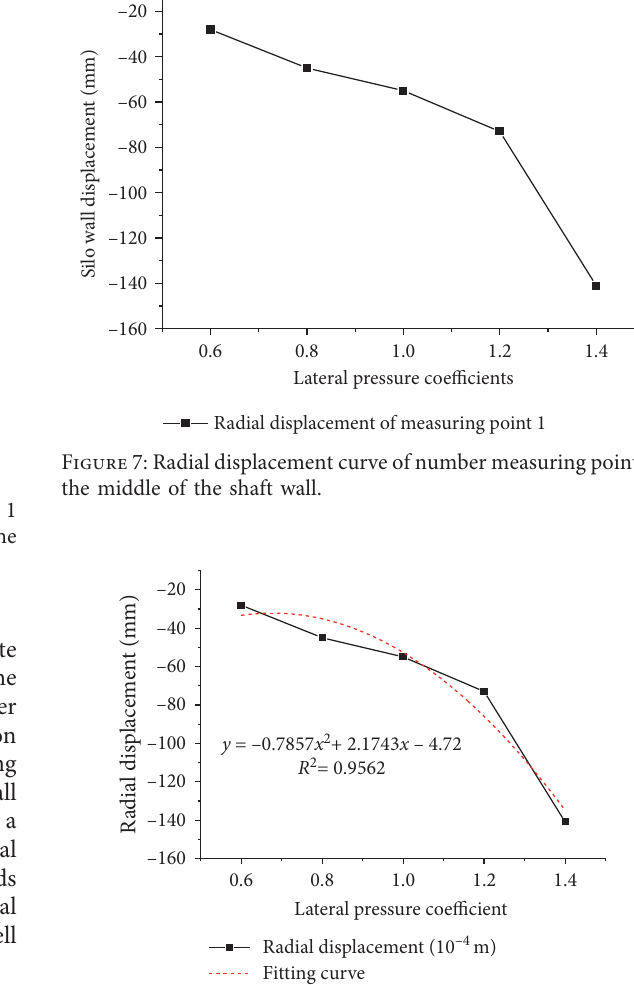
Figure 8: Radial displacement fitting curve of number 1 measuring